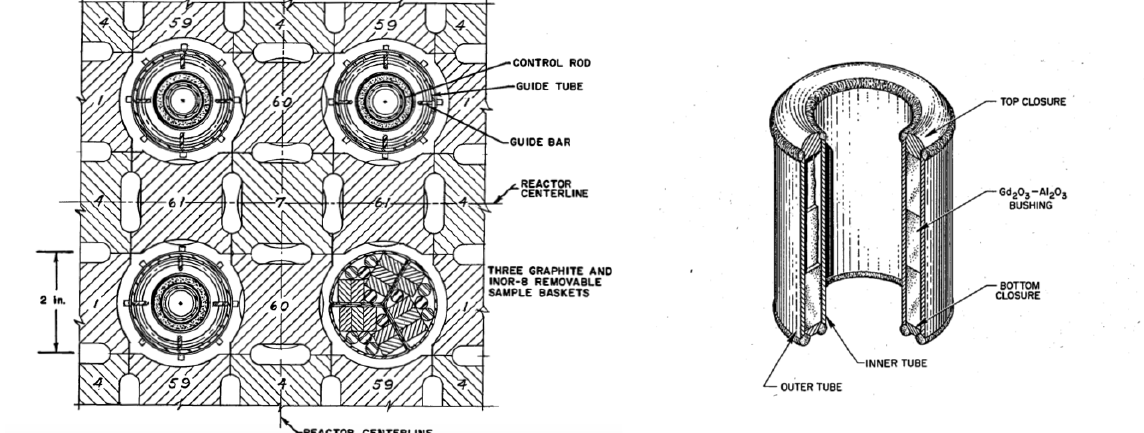
Figure 2. Control Rod and Sample Basket [2] (left); cutaway of a Control Element [3] (right). The reactor vessel is installed in a stainless-steel thermal shield that supports the vessel and forms the outer wall of the reactor furnace as shown in Figure 3. The shield has an approximate outer diameter of 317.5 cm and an inner diameter of 236.22 cm.